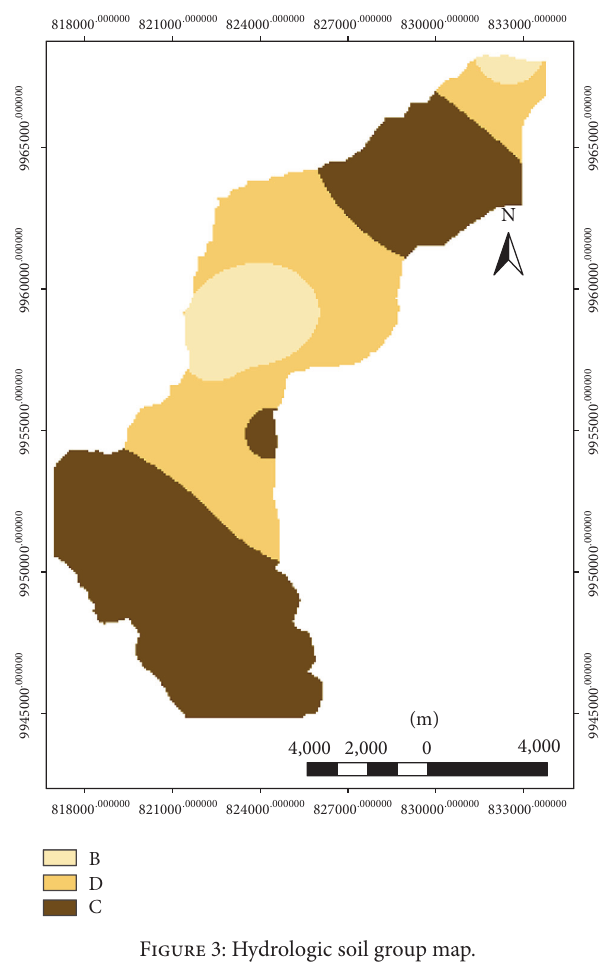
Figure 3: Hydrologic soil group